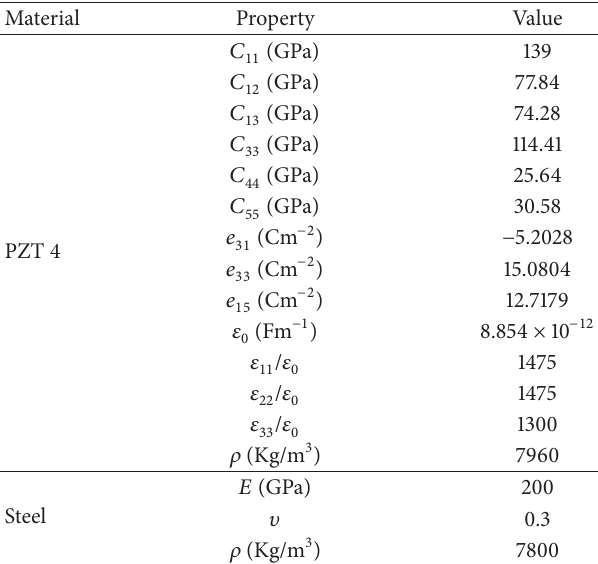
Table 1: PZT and steel material properties.